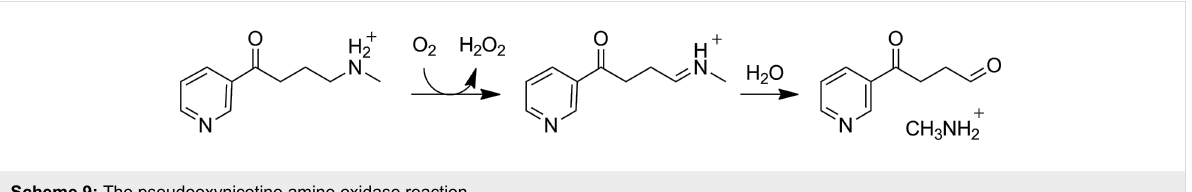
Scheme 9: The pseudooxynicotine amine oxidase reaction.